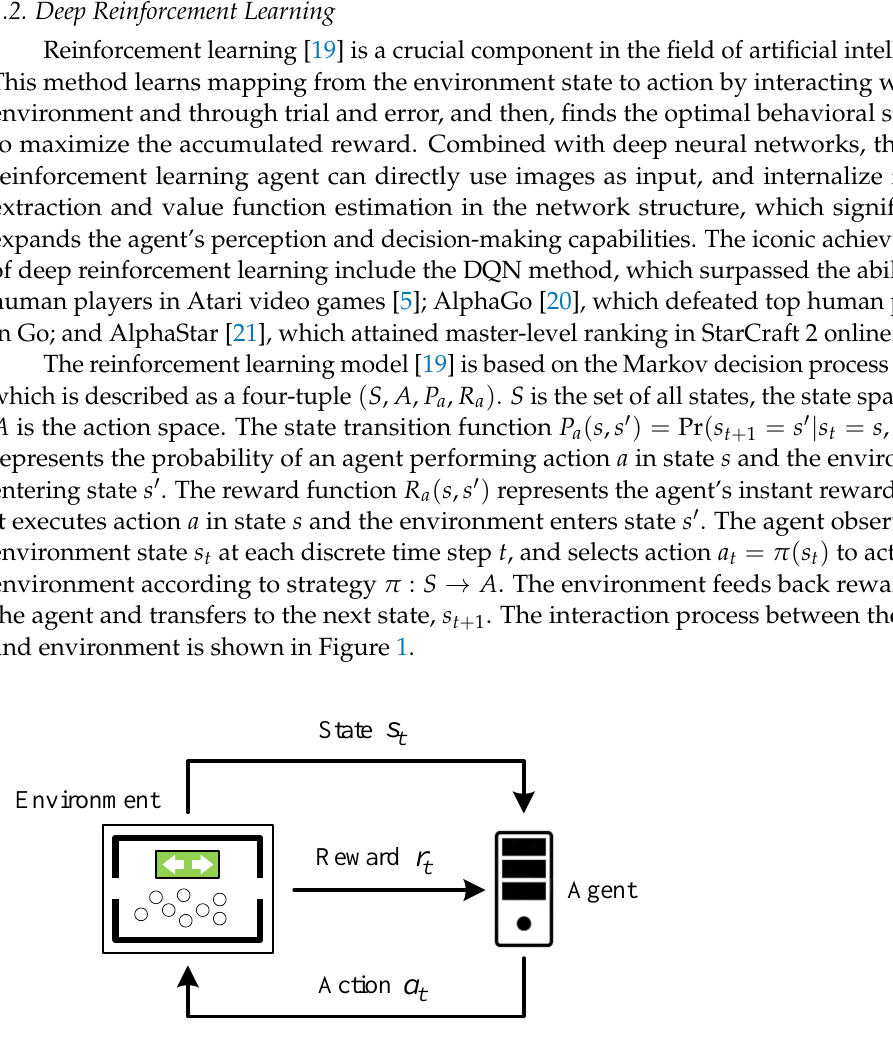
Figure 1. Schematic of reinforcement learning